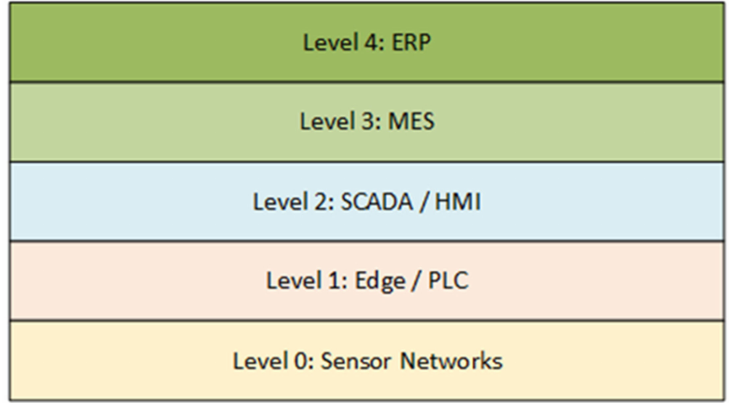
Figure 1. ISA-95 architecture for industrial automation